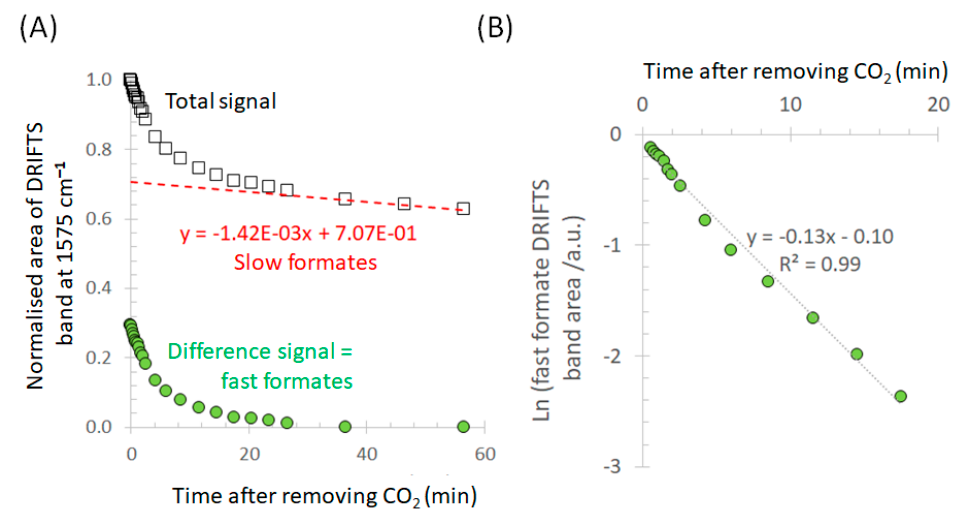
Figure 4. ( A ) Evolution of DRIFTS band area recorded over Cu/ZrO 2 at 220 °C as a function of time under 85% H 2 in He. The time range 1–60 min is presented. The total signal (open square) could be decomposed into a slow linear contribution (red dotted line) and a faster decay (green circles). Total flow = 100 mL min − 1 . ( B ) Semi-logarithmic plot of the normalized signal associated with the faster decay showing a linear behavior.